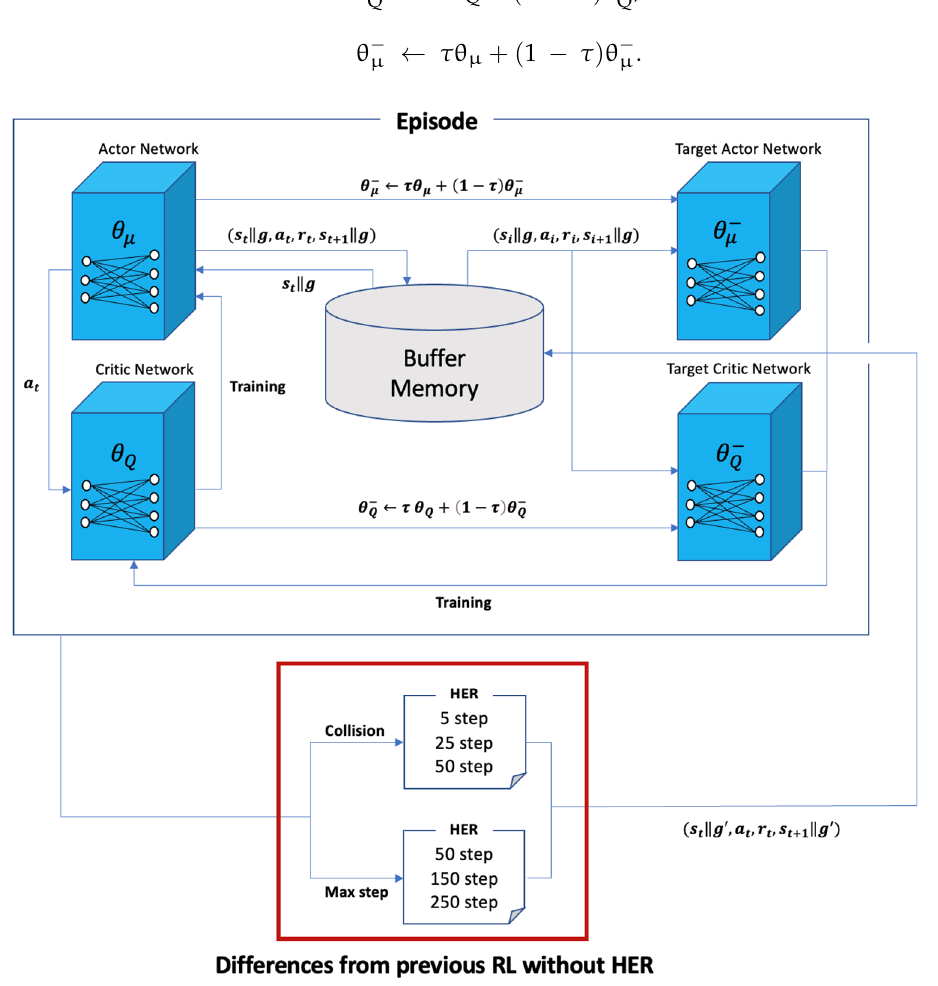
Figure 7. Overall system illustration of reinforcement learning based on deep deterministic policy gradient (DDPG) with HER.